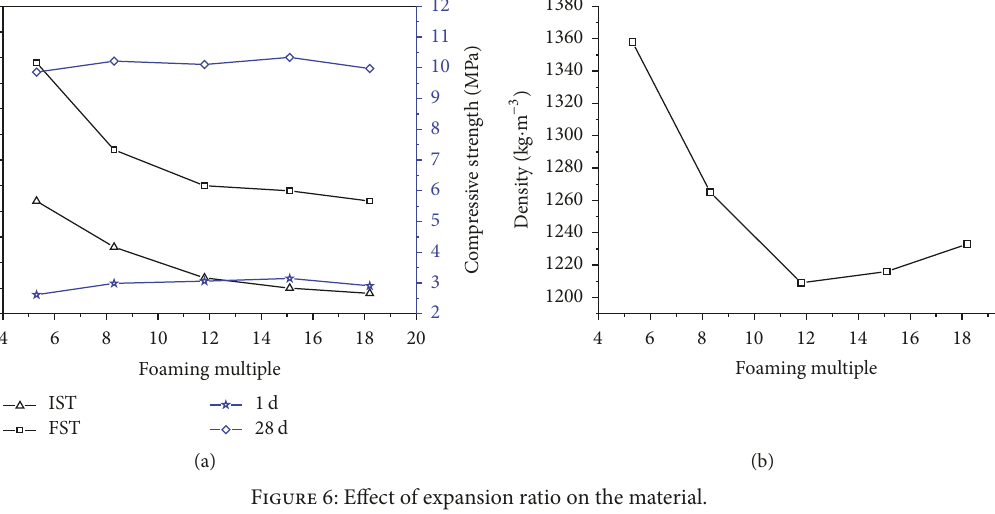
Figure 6: Effect of expansion ratio on the material.